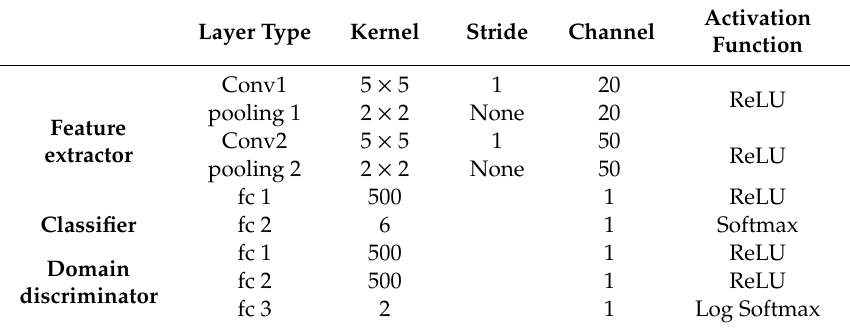
Table 2. Details of the network and